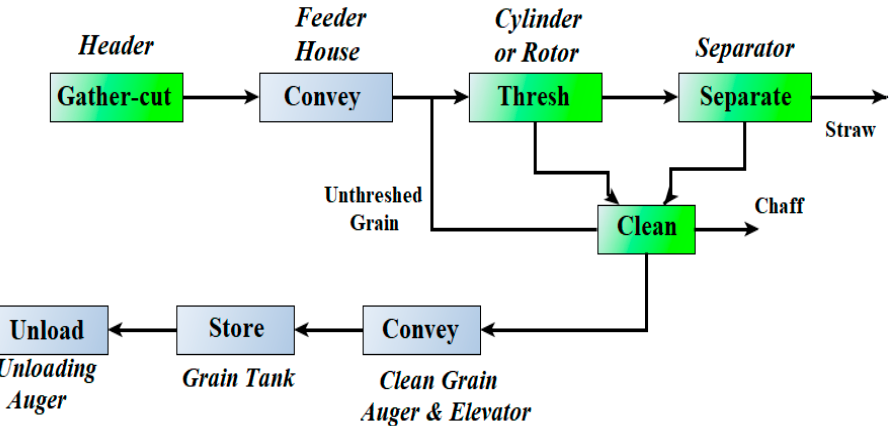
Figure 1. Combine harvester operation procedure highlighting where losses typically